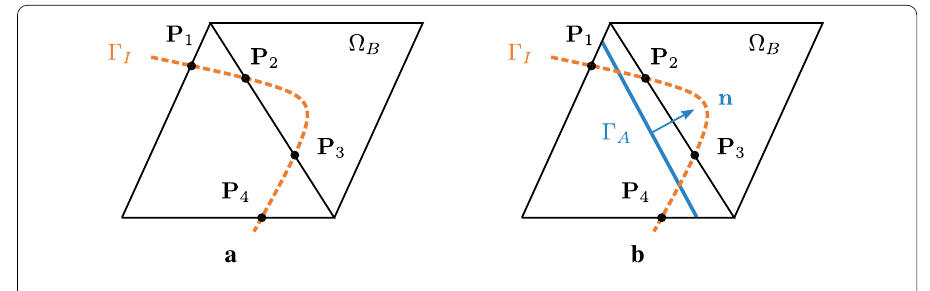
a b Fig. 14 Approximation strategy for immersed geometries that are slightly curved and lead to double-intersected edges. a Conceptual illustration of the problem. b Conceptual illustration of the solution